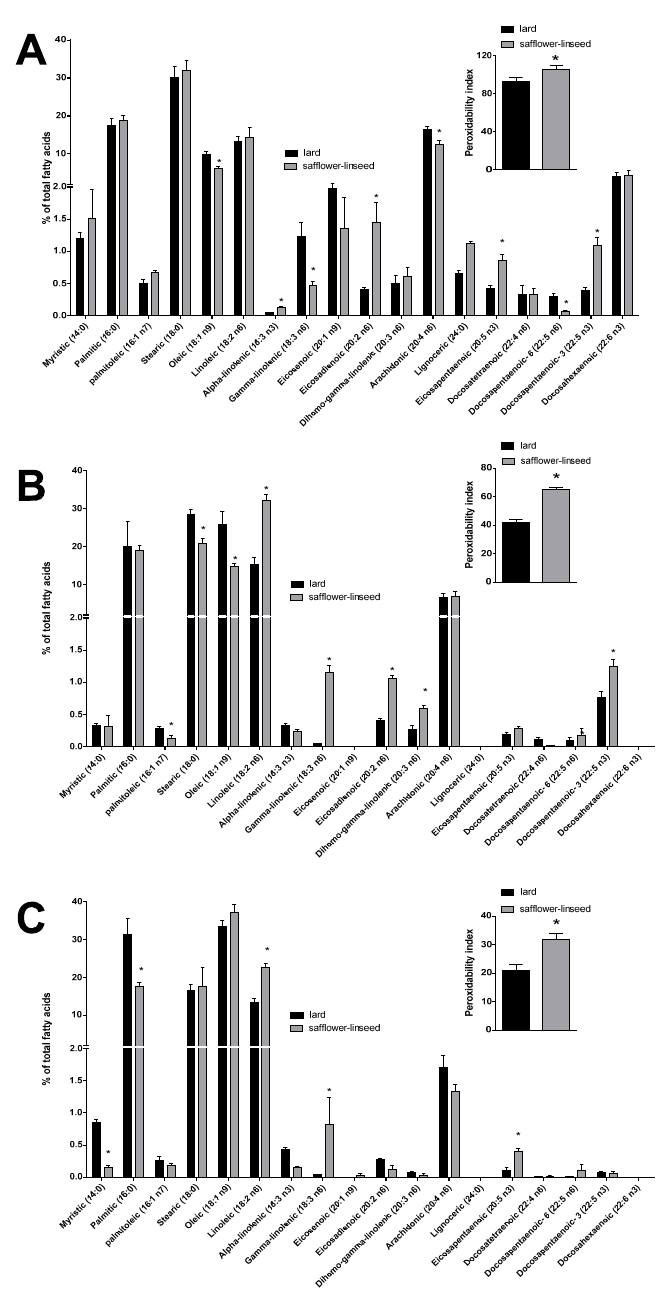
Figure 5. Percentage molar distribution of fatty acids and peroxidative index (inset) in hepatic mitochondria ( A ), hepatic tissue ( B ), and plasma ( C ) of rats fed lard or safflower-linseed high fat diet. Values are reported as means with their standard errors. n = 8 different rats. * p < 0.05 compared to lard.